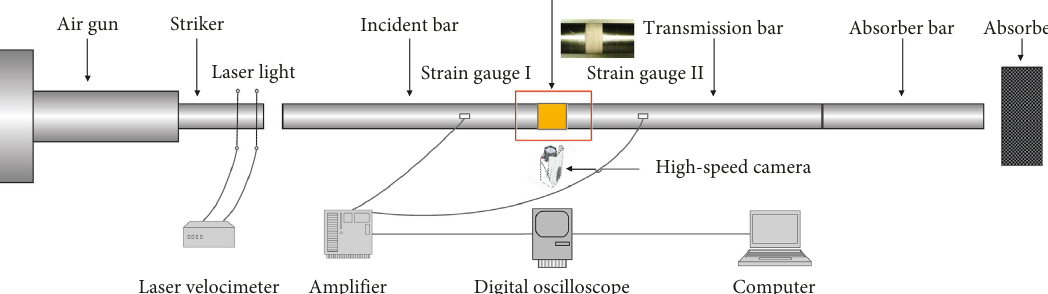
Figure 6: Structural characteristic of the SHPB.